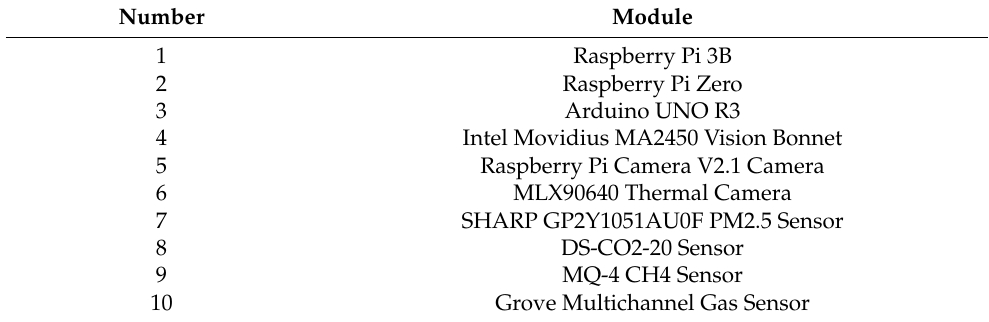
Table 2. iMonitor modules.